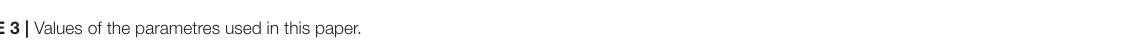
TABLE 3 | Values of the parametres used in this paper. µ a